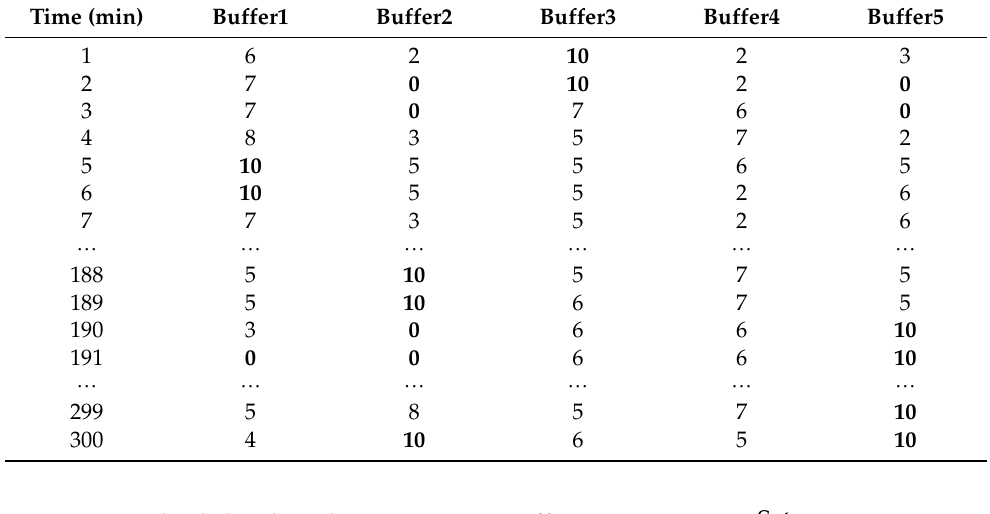
Table 7. Buffer capacity change table.